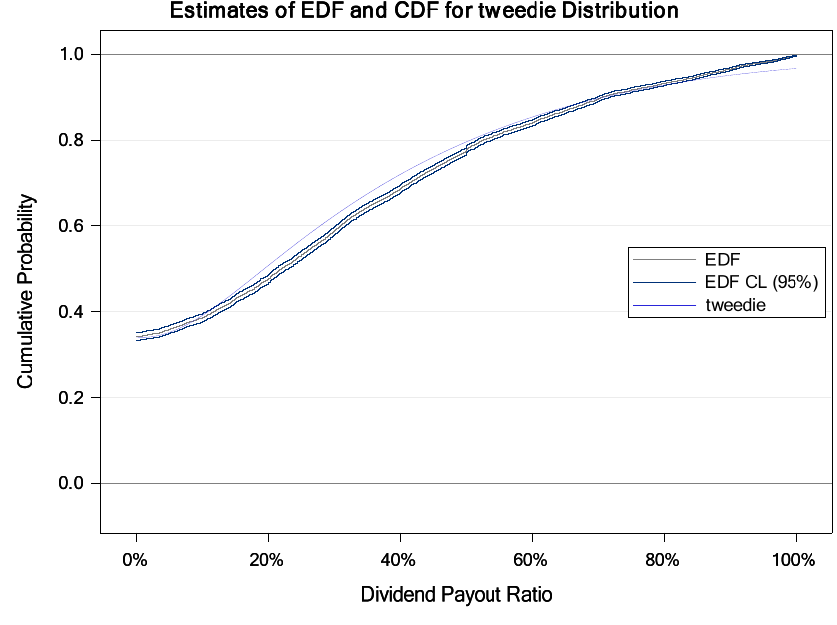
Figure 3 : Empirical Distribution Function of Dividend Payout Ratio (EDF) versus the estimated Tweedie Cumulative Distribution